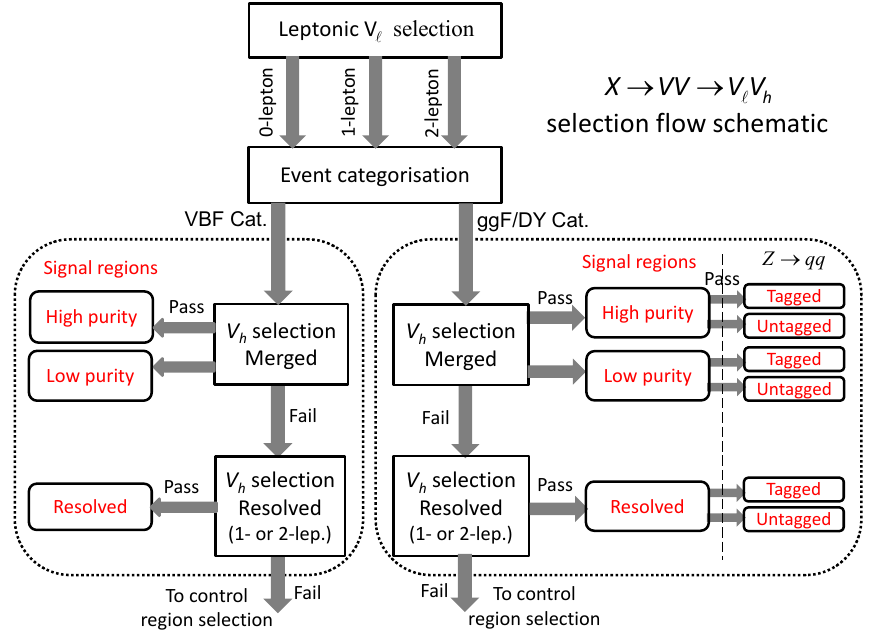
VV V (cid:96) V h search. Here, (cid:96) and h → →